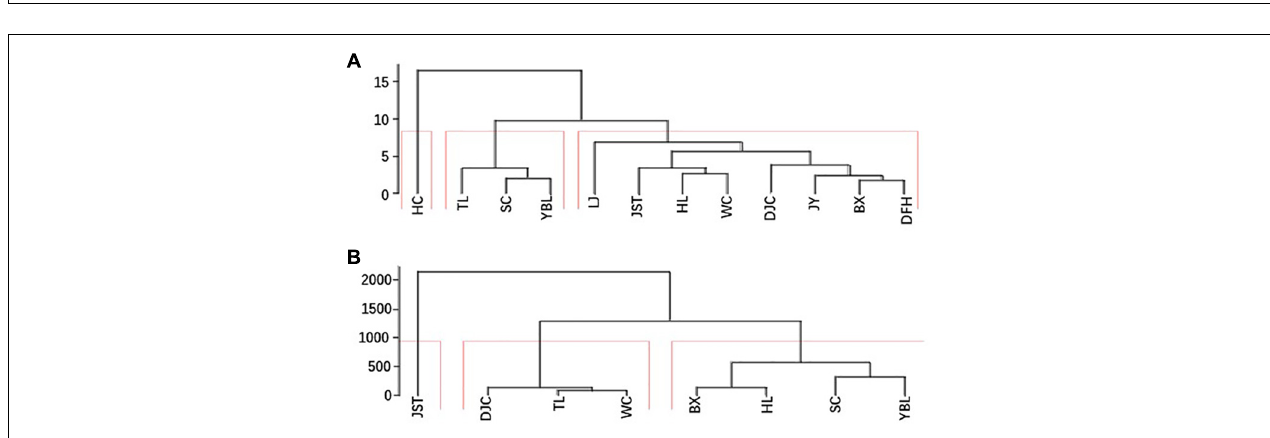
FIGURE 5 | Correlation between kernel components and geographical factors. The content of zinc and vitamin B6 were plotted against the longitude as a representative.